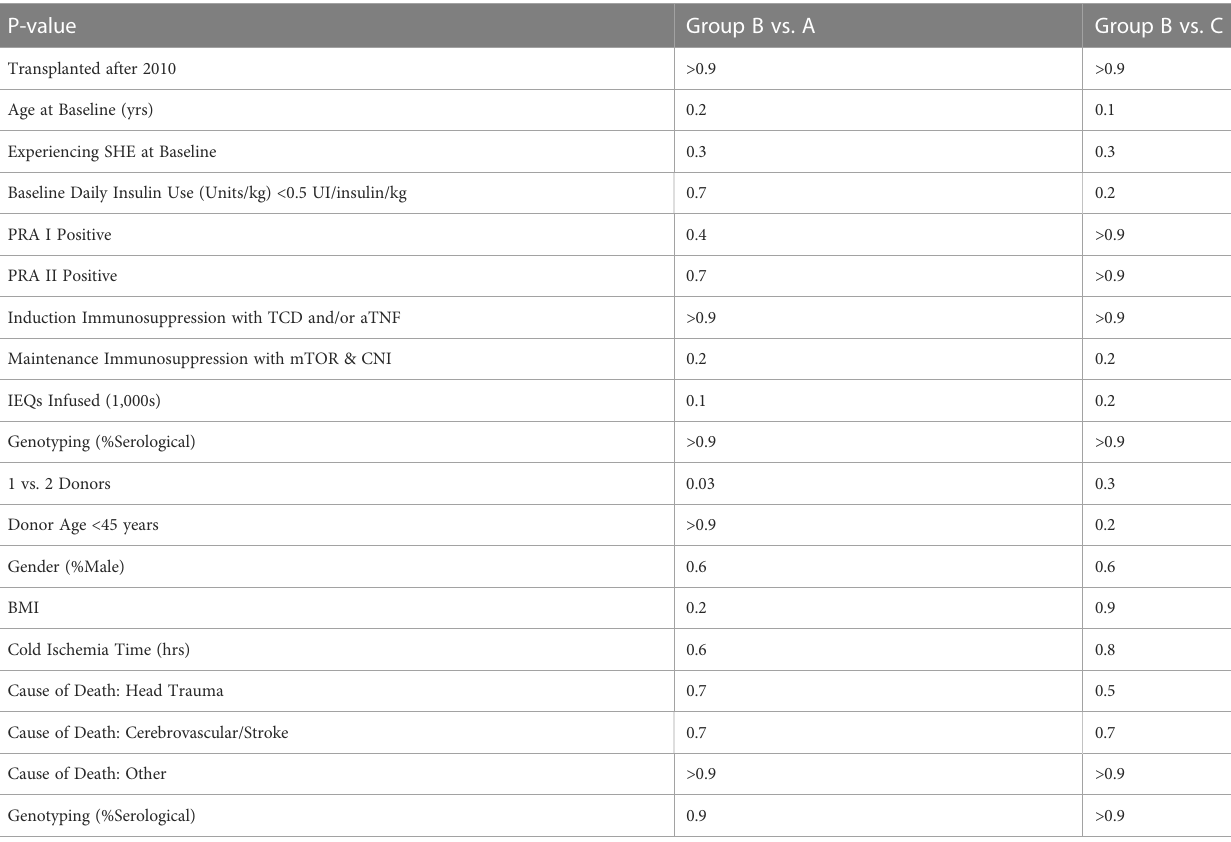
TABLE 3 Potential